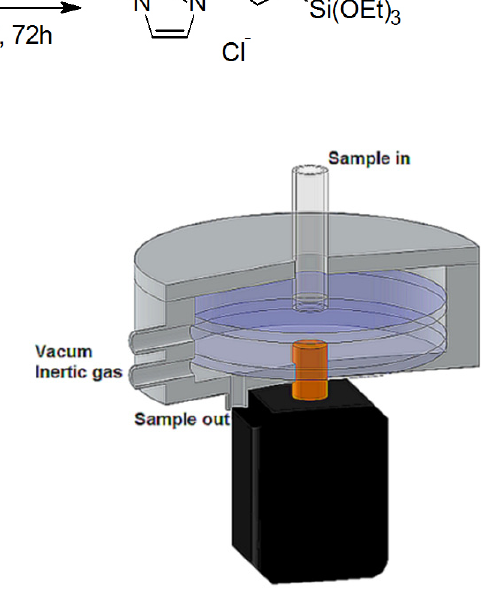
Figure 1: A figure of CNT-ionogel